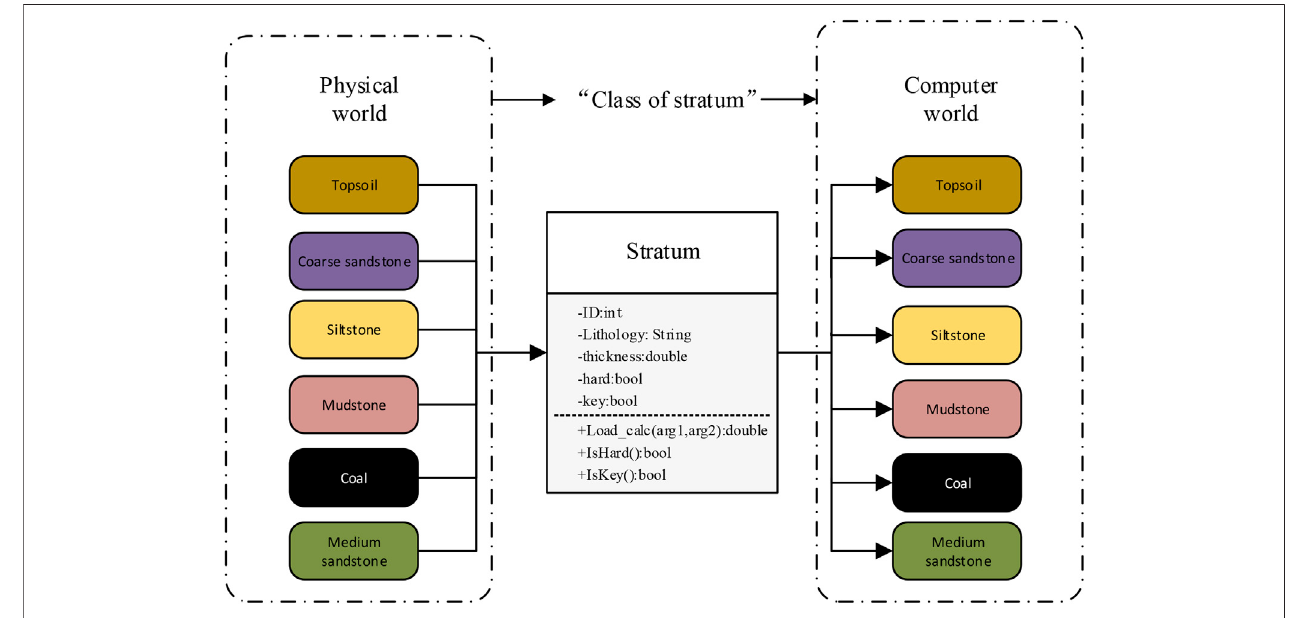
FIGURE 3 | The abstract analysis of rock strata.